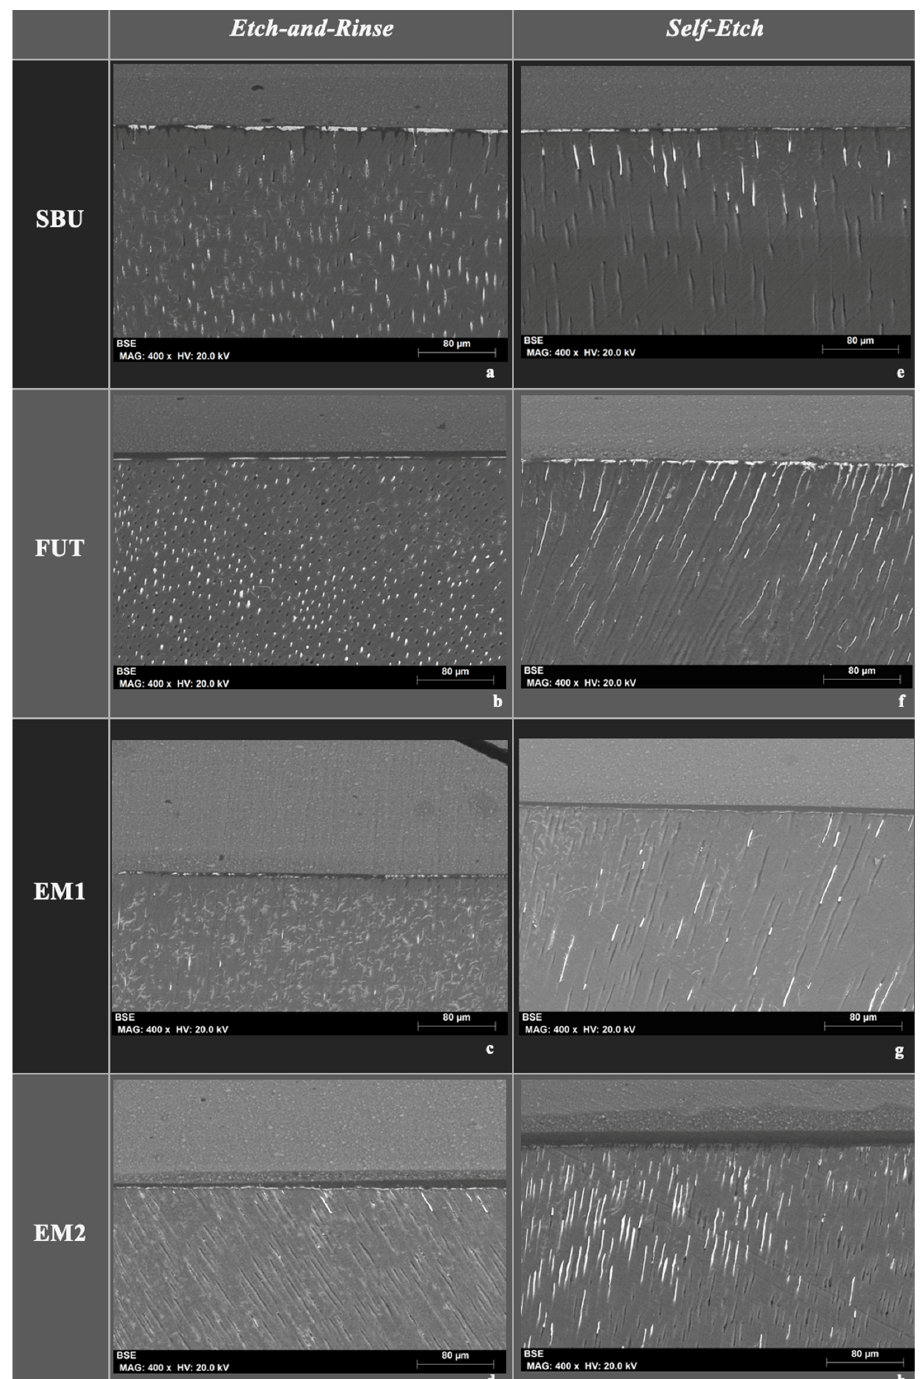
Figure 4. FEG-SEM images with backscattered electron detector of all universal adhesive systems (experimental and commercial) when applied under ER or SE strategies, at 400× magnification. ( a ) shows SBU in etch-and-rinse, while ( e ) shows SBU in self-etch mode, ( b ) shows FUT in etch-and-rinse and ( f ) in self-etch, ( c ) shows experimental EM1 in etch-and-rinse and ( g ) in self-etch and ( d ) EM2 in etch-and-rinse while ( h ) in self-etch mode. It is possible to observe the silver nitrate deposit zones on the adhesive interface which correspond to white spots with a granular appearance. These were more intense in ER strategies, compared to SE. Experimental materials EM1 and EM2 show a competitive nanoleakage performance to commercials, with EM1 showing less intensity than